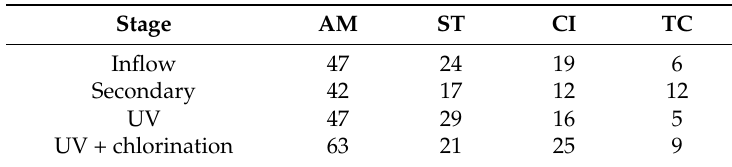
Figure 2. Cumulative precipitation (7 days total) before each sampling event. Table 3. The percentage of E. coli growth on media supplemented with antibiotics through the treatment